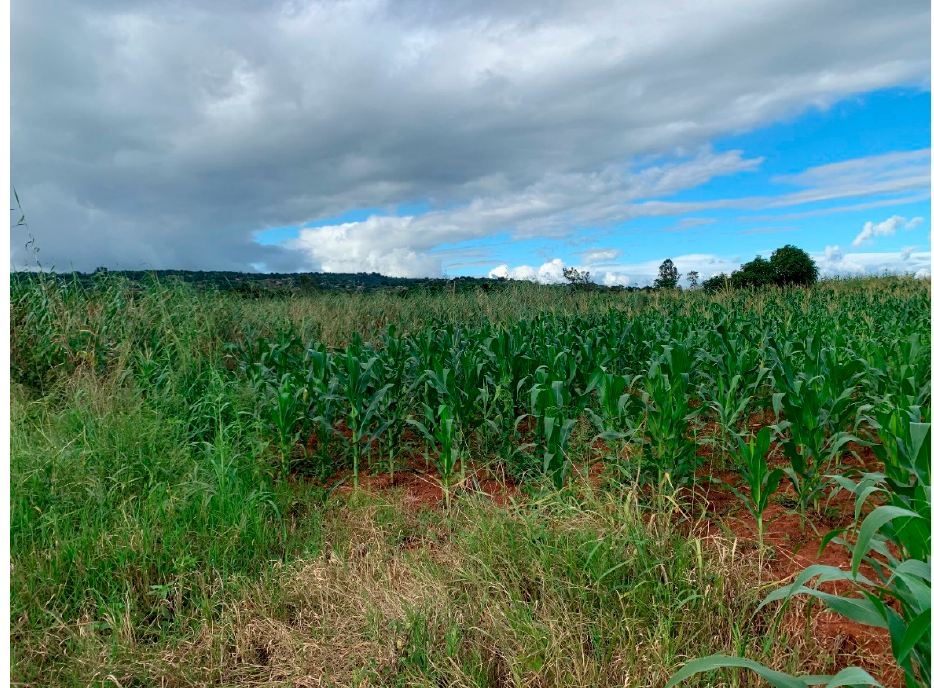
Figure 3. Cultivation in wetlands in the study